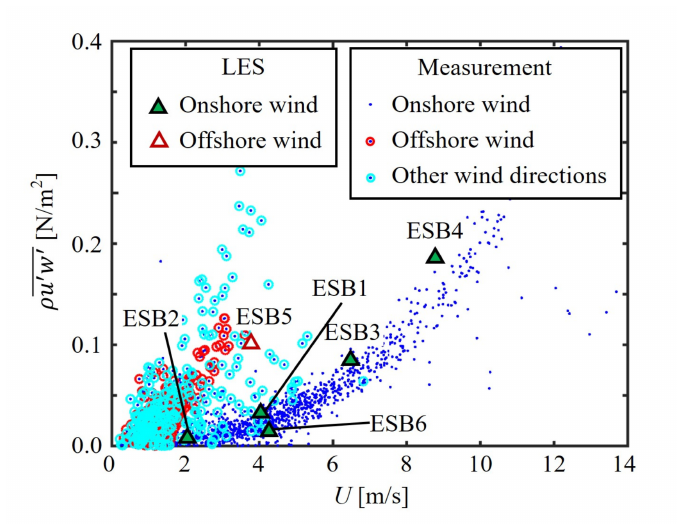
Figure 6. Turbulence momentum flux ρ u (cid:48) w (cid:48) versus mean velocity U at location B in cases ESB1–ESB6. The measurement data at the same location are superposed.